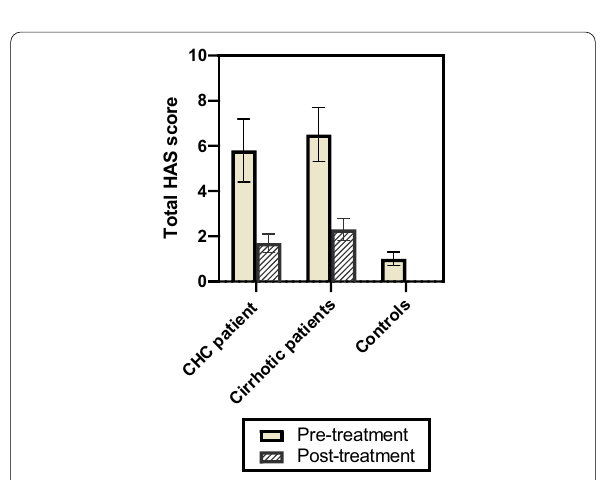
Fig. 2 Total HAS score among the studied groups